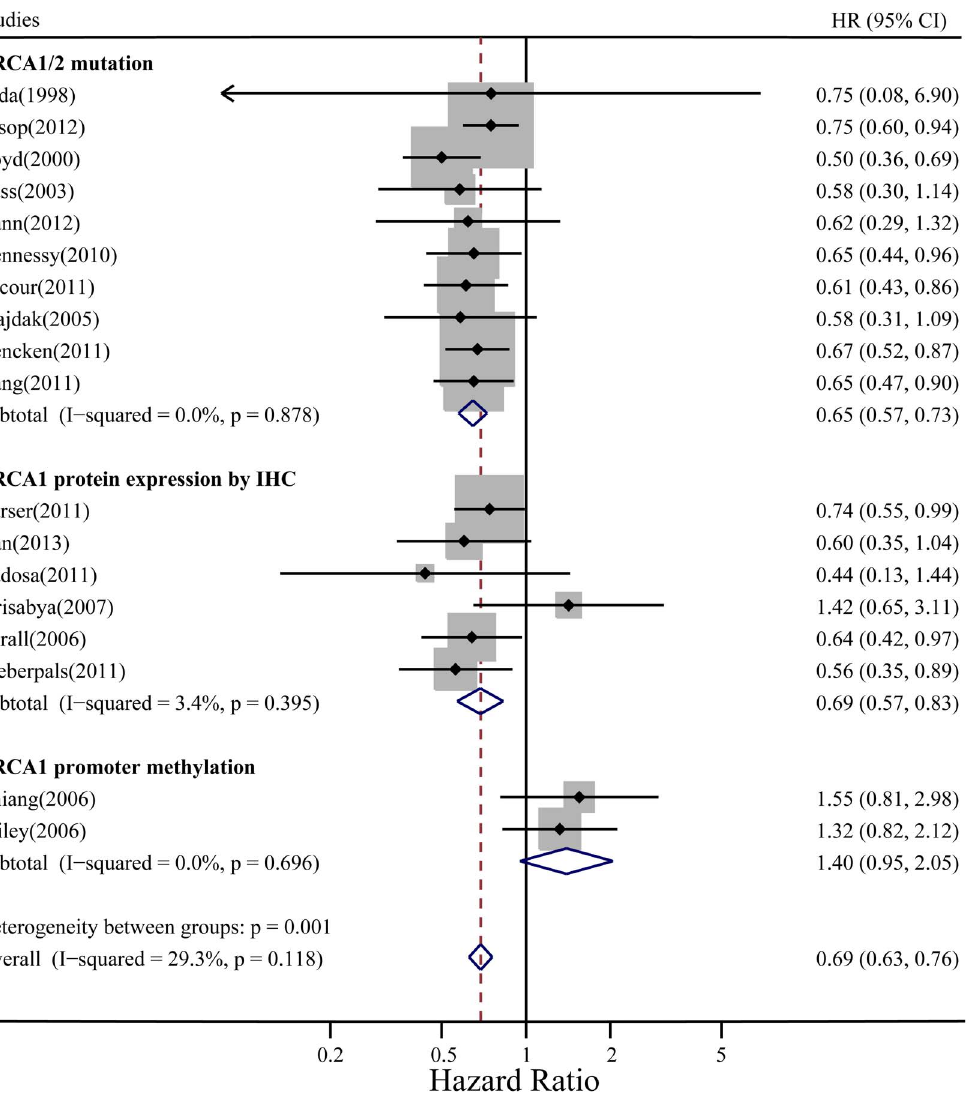
Figure 4. Summary hazard ratios (HRs) and 95% confidence intervals (CIs) of ovarian cancer PFS for BRCA dysfunction status. Horizontal lines represent 95% CIs; diamonds represent summary estimates with corresponding 95% CIs. Test for heterogeneity: P =.118, I 2 =29.3%. A fixed-effects model was used.